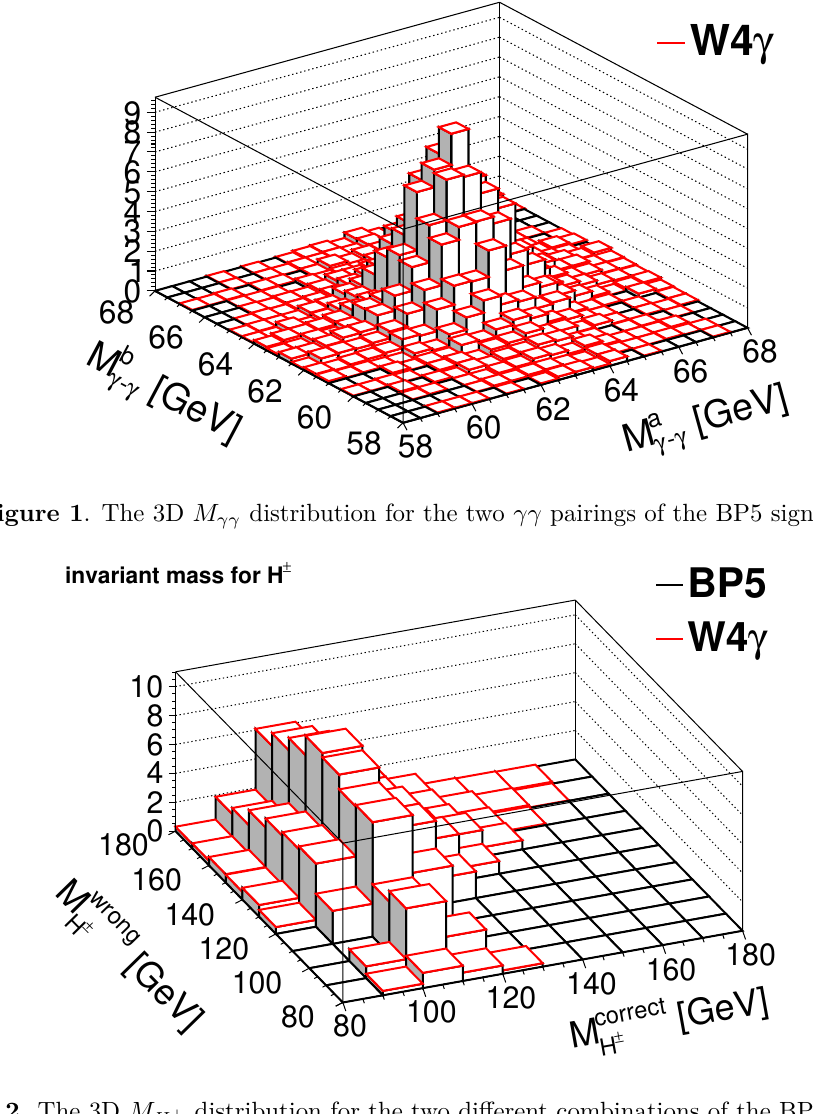
distribution for the two different combinations of the BP5 Figure 2 . The 3D M H ±